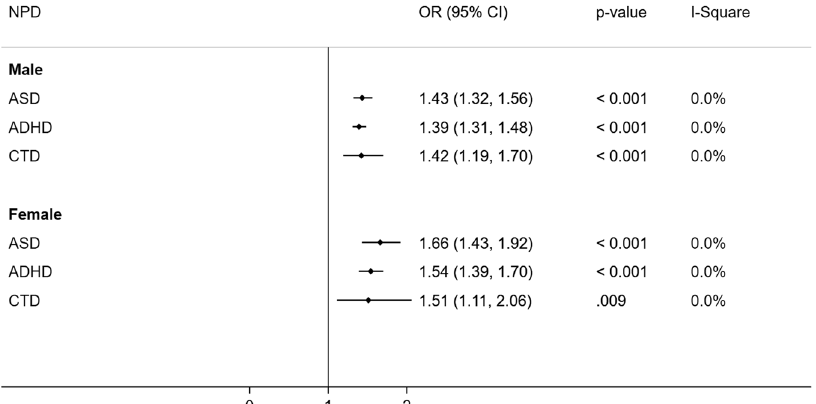
Fig. 3 Association of maternal PCOS and NPD in children by their sex. PCOS polycystic ovary syndrome, NPD neuropsychiatry disorders, OR odds ratio, CI con fi dence interval.